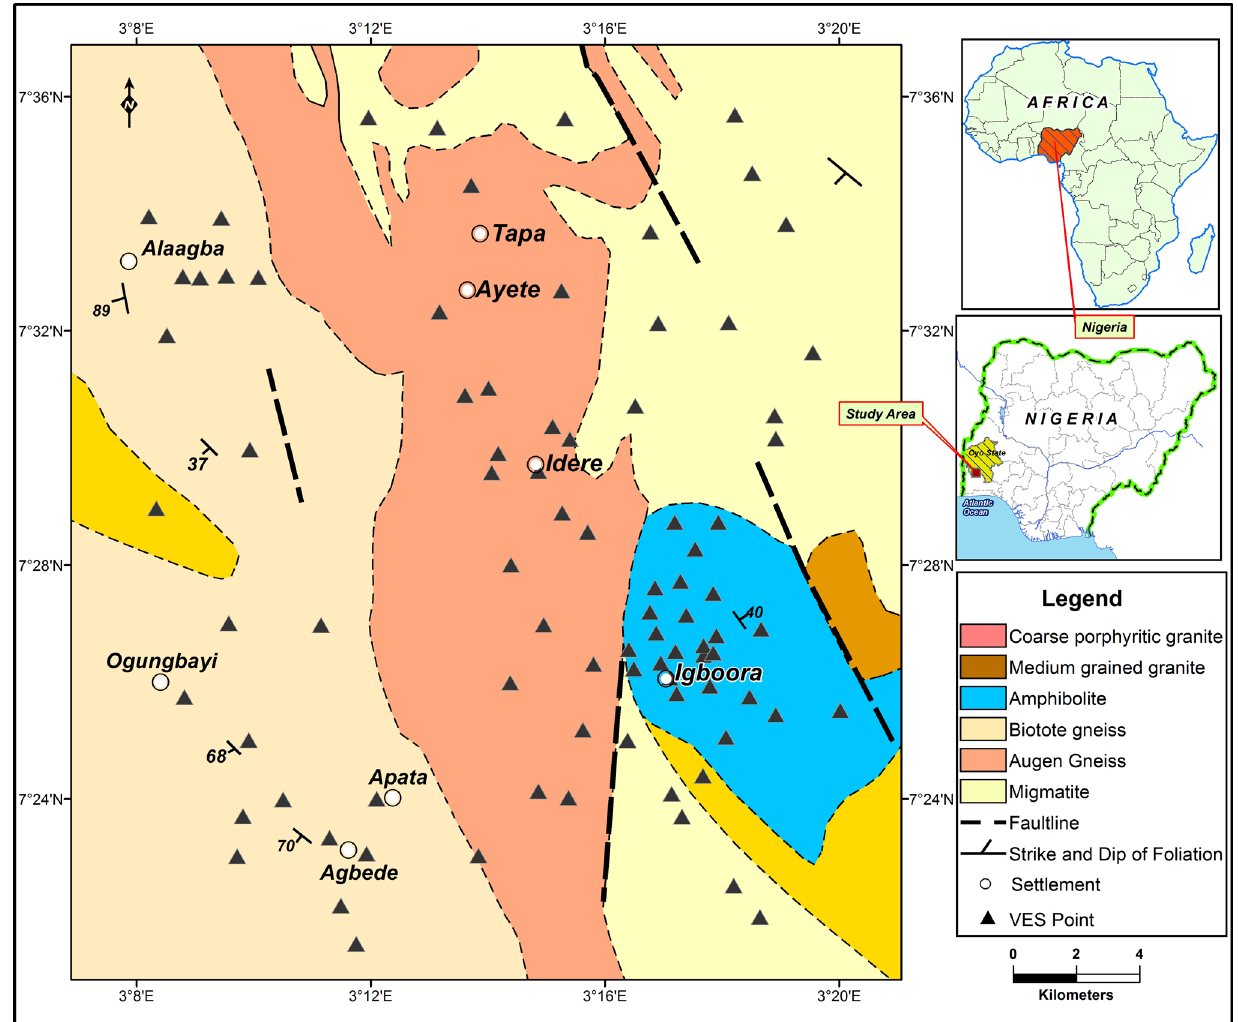
Fig. 3 Locations of VES points on geological